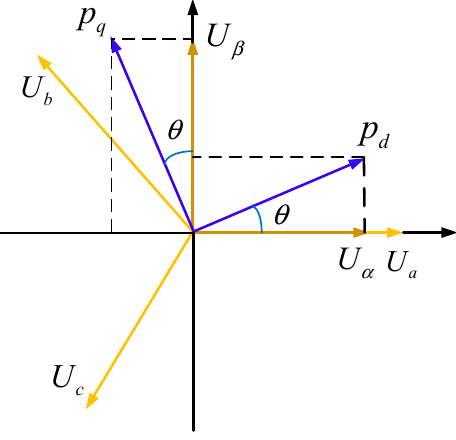
Figure 4. Coordinate transformation.